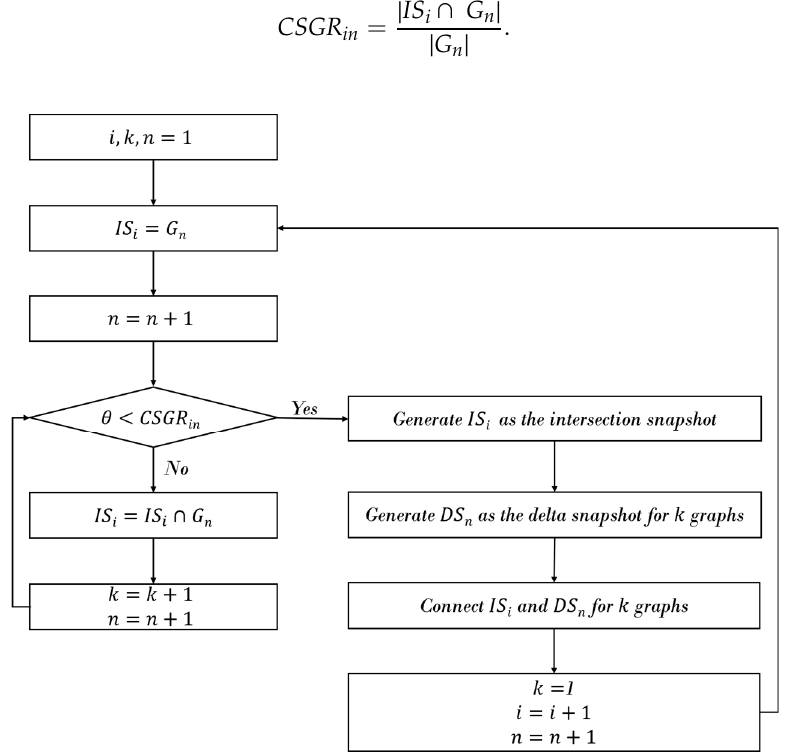
Figure 2. The process of generating the overall snapshot.